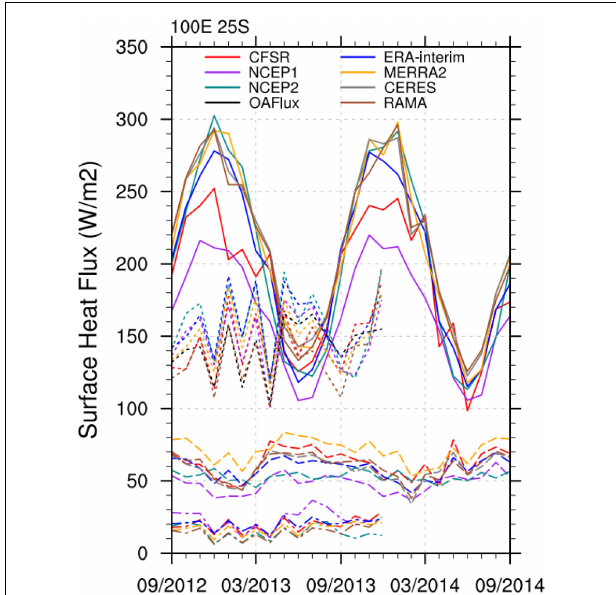
FIGURE 3 | Comparison of monthly mean surface heat fluxes from reanalysis products with those from RAMA buoy observations at 100 ◦ E, 25 ◦ S: net shortwave radiation (solid line), net longwave radiation (dashed line), latent heat flux (dotted line) and sensible heat flux (dot-dashed line). Positive values indicate the flux into the ocean (atmosphere) for shortwave radiation (longwave radiation, latent and sensible heat flux).